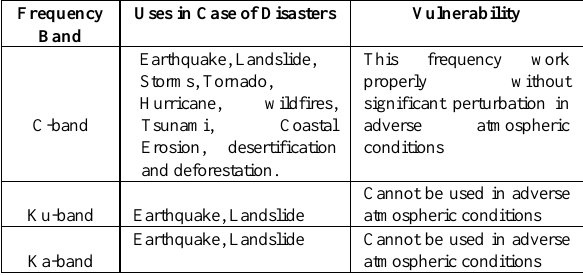
Table 5. VENESAT-1 Spectrum characterization for